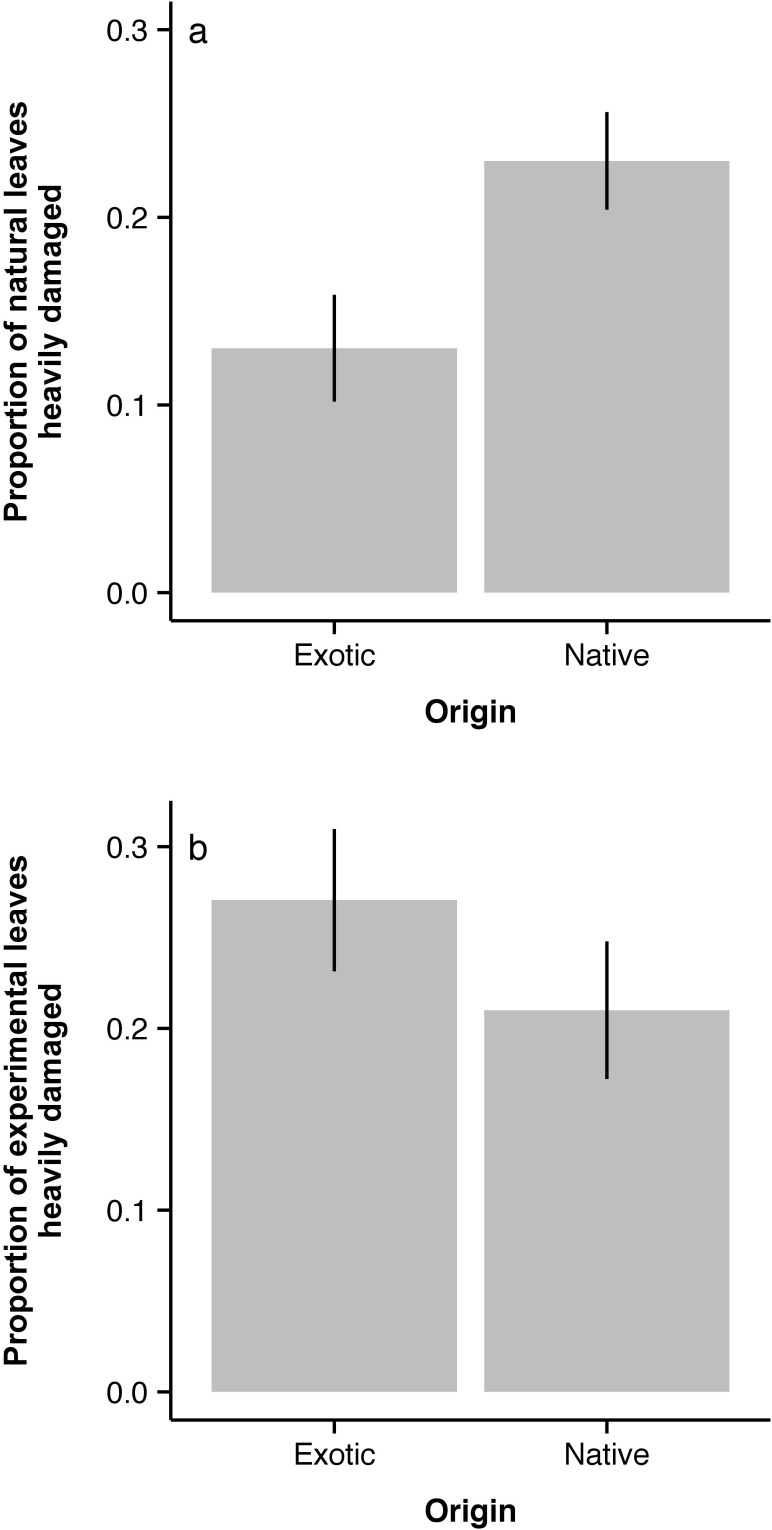
Comparison of beetle interactions with native and exotic Hypericum.(A) proportion of leaves heavily damaged by beetles in naturally occurring plants; (B) proportion of leaves heavily damaged in transect experiment plants.